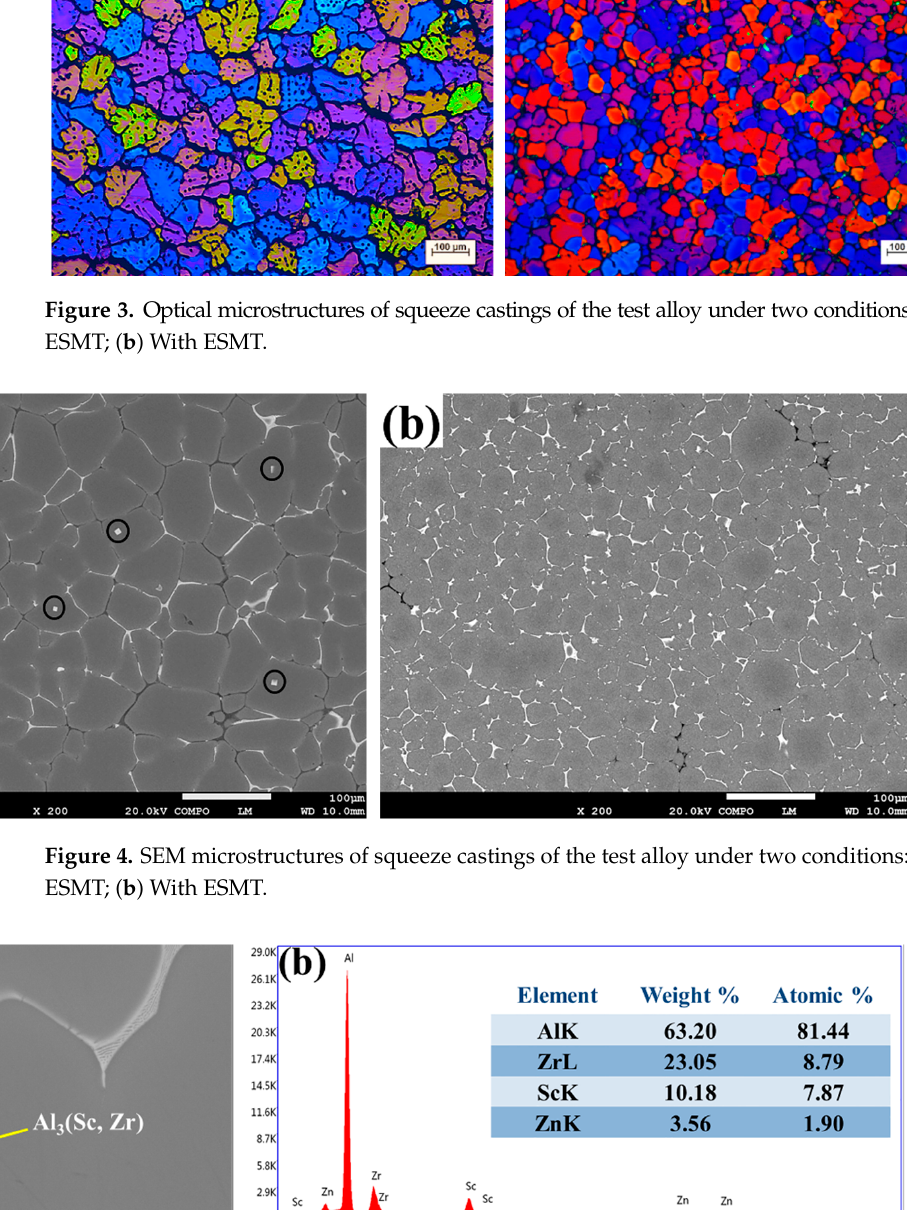
Figure 5. Coarse bulk primary Al 3 (Sc, Zr) phase ( a ), and EDS analysis result ( b ) in SEM microstruc- tures of squeeze castings without ESMT.